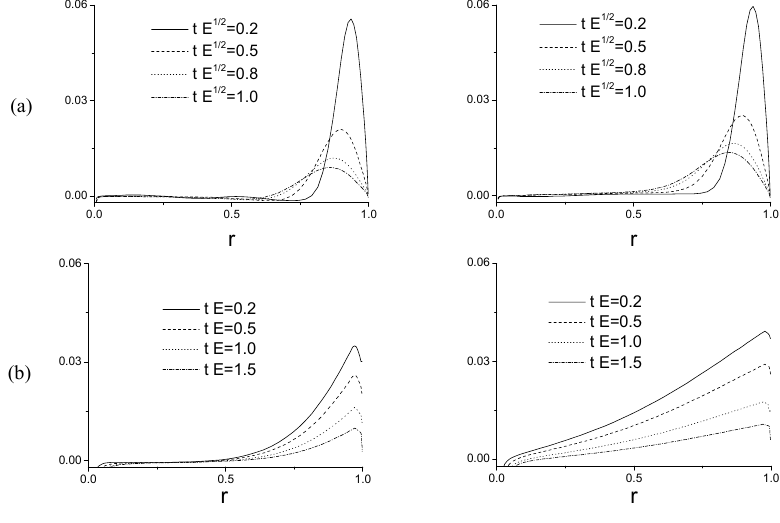
Fig. 7 The radial and sequential plots of the magnitude of viscous-diffusion term (z=0.5). (For left figures, S=1.0; for right figures. S=10.0.) (a) t c = E 0 ; (b) t c =E -1